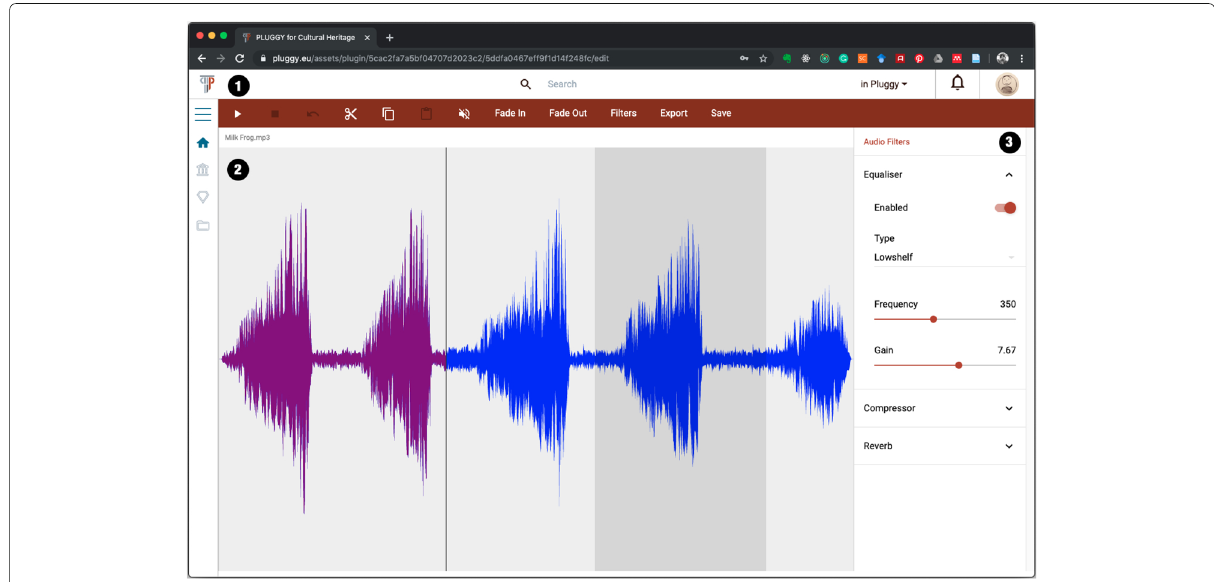
Fig. 3 PlugSonic Sample User Interface